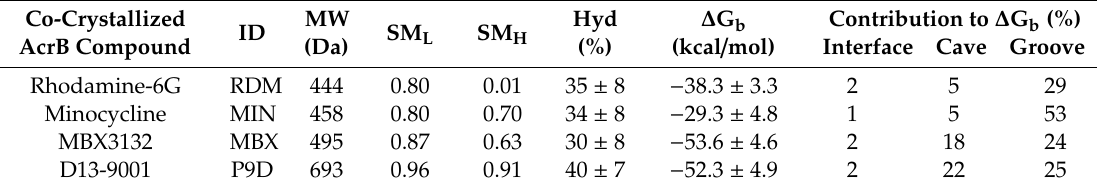
Table 1. List of substrates and inhibitors co-crystallized with AcrB and considered in this study, along with their molecular identifier and molecular weight (MW). The central columns report the hydrophobic (SM L ), and hydrophilic surface matching (SM H ), and the percentage of water molecules in the first solvation shell (Hyd) calculated against molecular dynamics (MD) simulations of the corresponding compound in water solution. The remaining columns report respectively the free energy of binding ( ∆ G b ) for the most populated cluster trajectory identified for each simulation, and the percentage contribution to ∆ G b from residues lining the interface between access pocket and DP T , the cave, and the groove regions of the DP T (see Figure 1 and residues list in Table